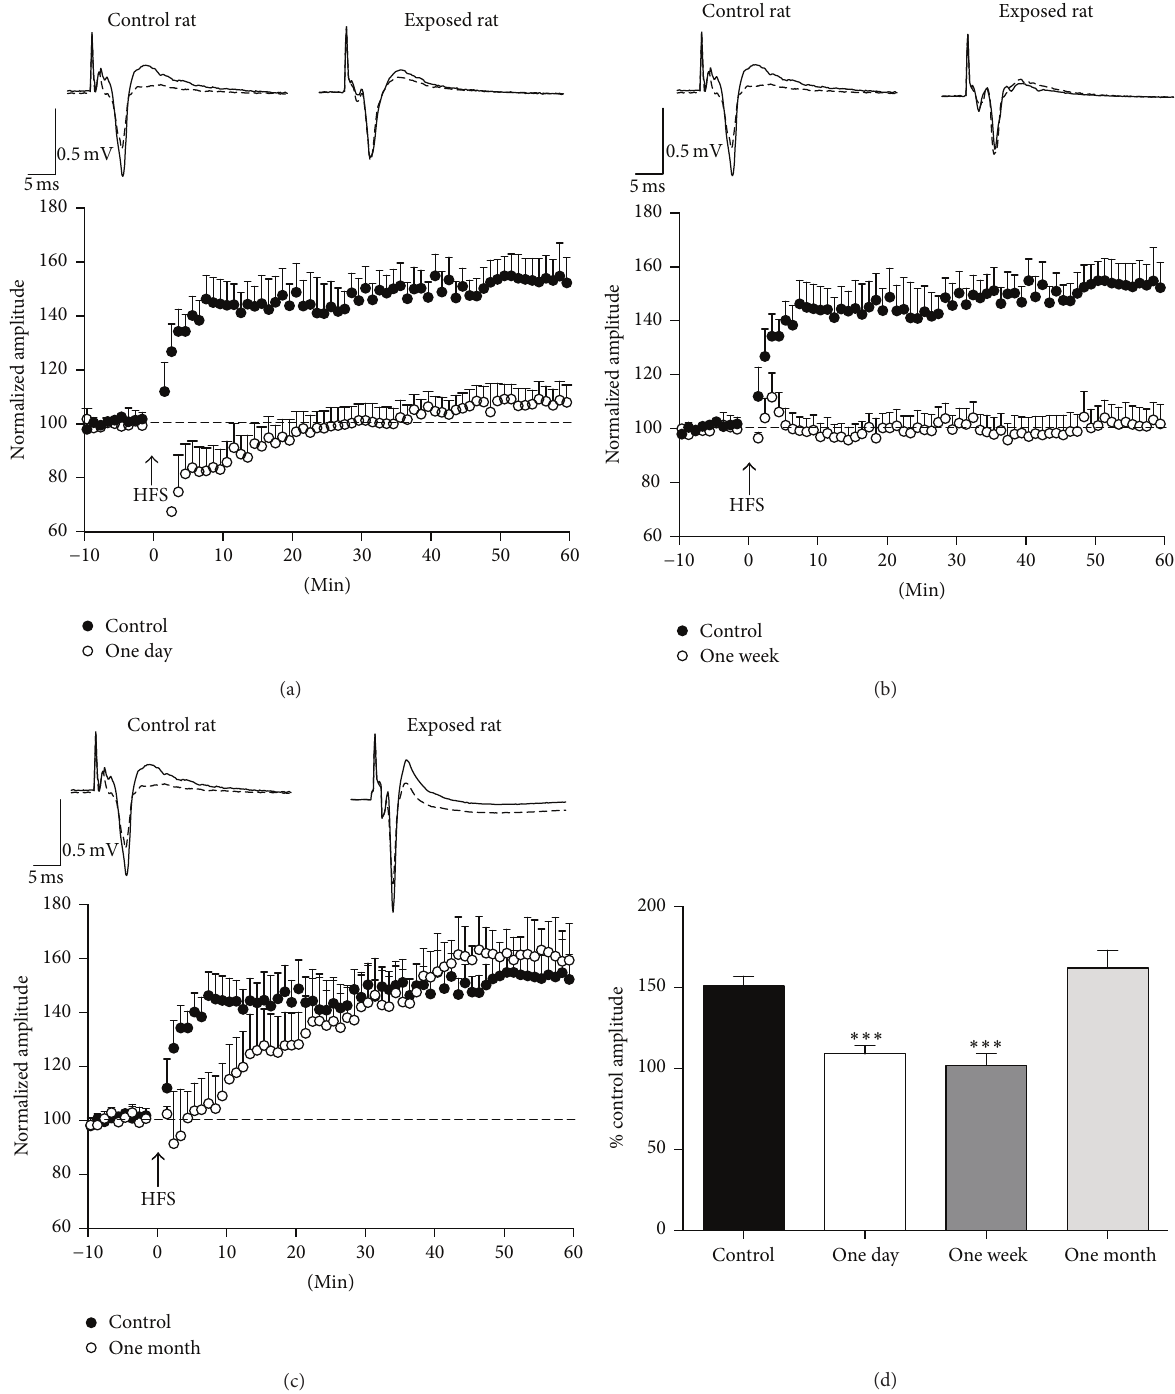
Figure 2: Effects of repeated isoflurane exposures on LTP in the BLA. Field potentials were evoked in the BLA by stimulation of the external capsule. (a), (b), and (c) show the time course of changes in the amplitude of the responses after high-frequency stimulation (HFS), in control rats (black circles) and rats exposed to three sessions of 1h isoflurane anesthesia, with a 48h interval between sessions (open circles); LTP studies were performed at 1 day (a), 1 week (b), and 1 month (c) after the last exposure. The amplitudes of three responses recorded in each min (stimulation at 0.05 Hz) were averaged, and each data point on the plot is the mean and standard error of these averages, from 9 to 13 slices. Traces over the plots are examples from a control rat and from isoflurane-exposed rats; the superimposed field potentials are a baseline response and a response at 50 to 60 min after HFS (each trace is the average of 10 to 20 sweeps). The data are summarized in (d), for the amplitude of the field potentials during the 50 to 60 min time-window after HFS, expressed as % of the control amplitude. ∗∗∗ 𝑃 < 0.001 , 𝑛 = 10 for the controls, 𝑛 = 10 for the 1-day group, 𝑛 = 13 for the 1-week group, and 𝑛 = 9 for the 1-month